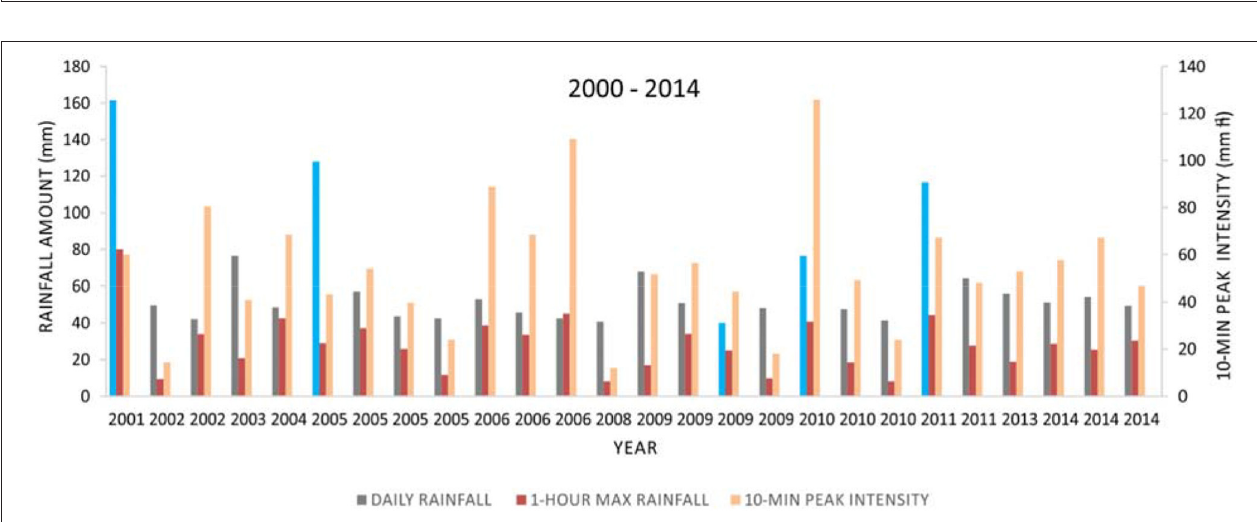
FIGURE 9 | Daily cumulative rainfall, 1-h max rainfall amount and 10-min peak intensity related to selected dates of the 2000–2014 time interval. Daily rainfall data associated to flash floods are highlighted in blue.